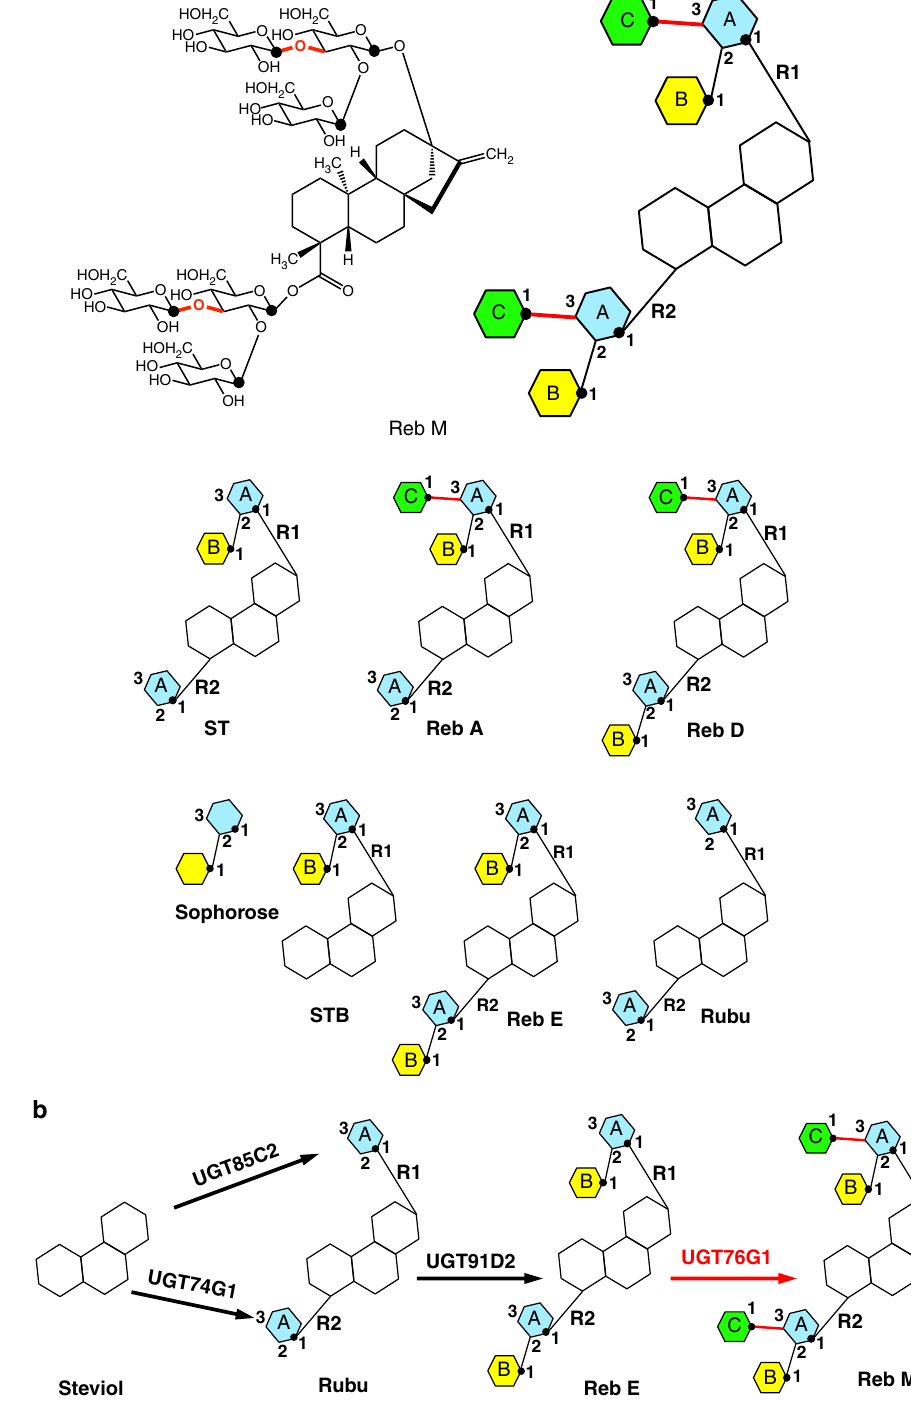
Fig. 1 The steviol glucosides related to UGT76G1 and the reactions in the biosynthesis pathway of steviol glucoside. a The chemical structure of Reb M and cartoon representations of the typical steviol glucosides Reb M, ST, Reb A, Reb D, sophorose, STB, Reb E, and Rubu. In the cartoon representation, the glycone units are represented by individually colored hexagons with the letters A, B, and C for clarity and the position of the 1-hydroxyl of glycone is marked by a black dot. All β (1 – 3) glycolic bonds formed by UGT76G1 are marked in red. b The reactions in the steviol glucoside biosynthesis pathway of Stevia rebaudiana Bertoni. The reaction and the glycosidic bonds involving UGT76G1 are labeled in